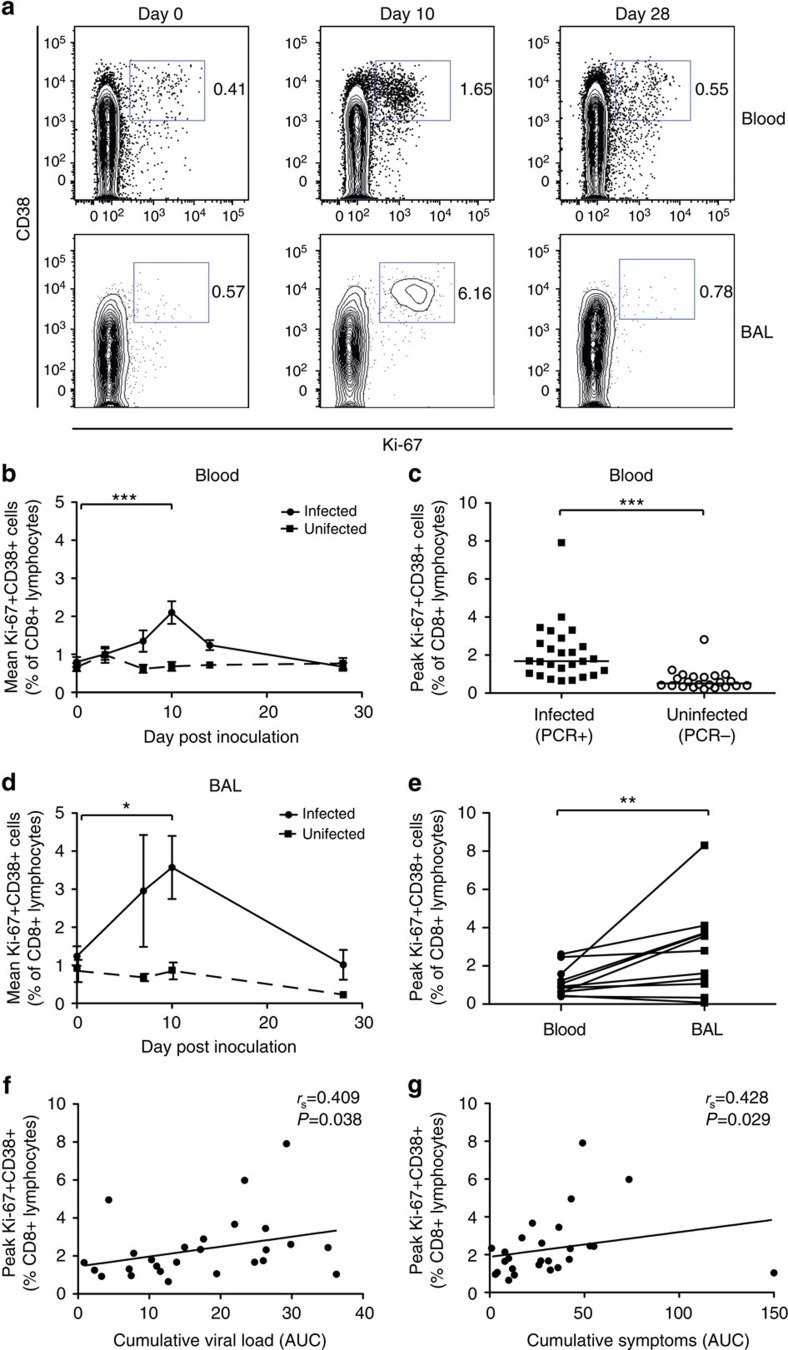
RSV infection induces short-lived activation and proliferation of CD8+ T cells in peripheral blood.Forty-nine adult volunteers were inoculated with RSV Memphis 37, serial blood (n=49) and BAL (n=24) samples were stained with anti-CD3, CD8, Ki-67 and CD38, and analysed by flow cytometry. (a) Plots are gated on CD3+CD8+ lymphocytes. Numbers represent percentage of CD8+ T cells. One representative subject is shown. (b) Mean and s.e.m. of Ki-67+CD38+ CD8+ T-cell frequencies in the blood of infected (PCR+) and challenged but uninfected (PCR−) are shown. The P value for a two-tailed Wilcoxon matched pairs test is shown (***P<0.001). (c) Frequencies of Ki-67+CD38+ cells as a proportion of CD8+ T lymphocytes were determined at day 10 post inoculation in infected and uninfected individuals. Mean±s.e.m. are shown with the P -value for a two-tailed Mann–Whitney test (***P=0.001). (d) Mean and s.e.m. of Ki-67+CD38+ CD8+ T-cell frequencies in the BAL of infected (PCR+) and challenged but uninfected (PCR−) are shown. The significant P value for a two-tailed Wilcoxon matched pairs test is shown (*P=0.0317). (e) Frequencies of Ki-67+CD38+ cells, as a proportion of CD8+ T lymphocytes were determined at day 10 post inoculation in matched blood and BAL samples. The significant P value for the Wilcoxon matched pairs tests is shown (**P=0.0059). Correlations between peak frequencies of Ki-67+CD38+ CD8+ T cells 10 days post infection in blood and (f) cumulative viral load and (g) symptoms (trapezoidal area under the curve (AUC)) are shown using non-linear regression and Spearman's rank correlation.